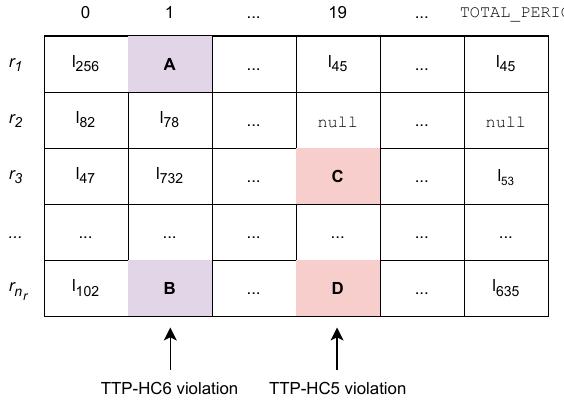
Figure 6. Example of hard constraints in a